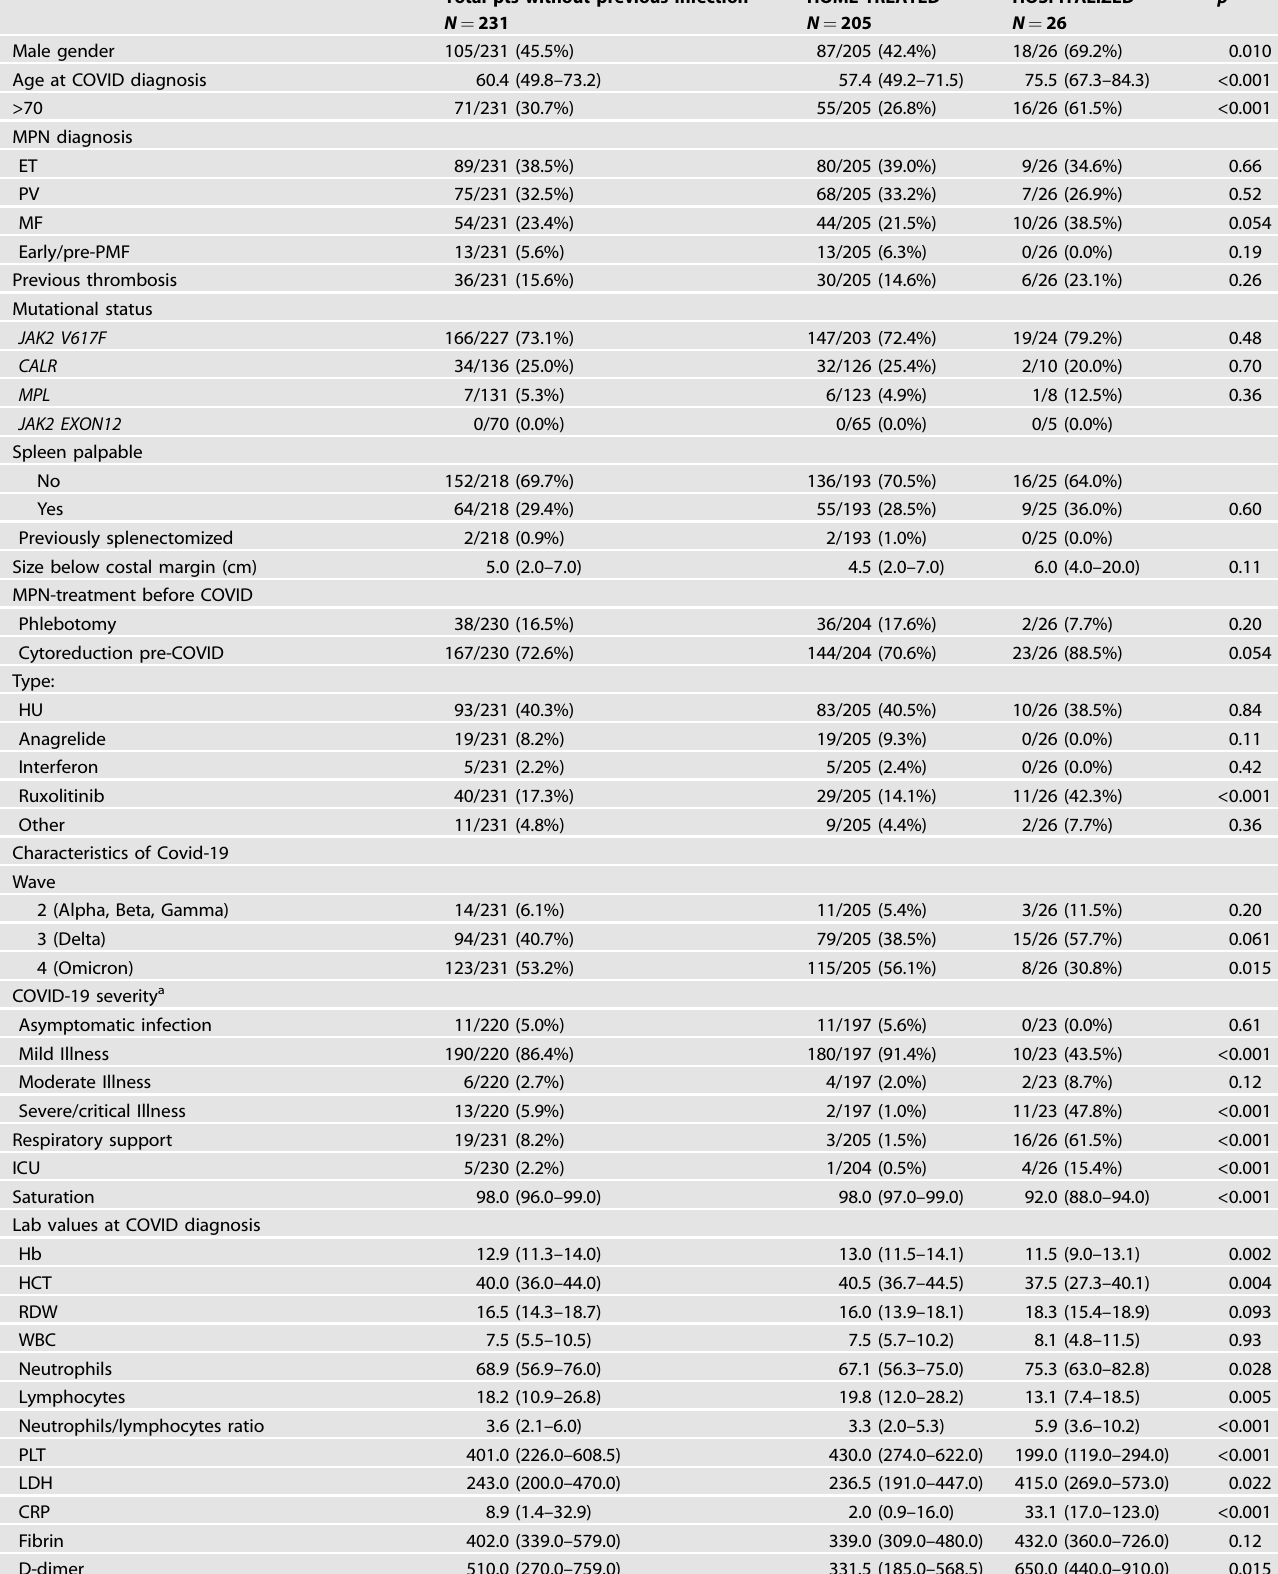
Table 2. Characteristics of vaccine breakthrough infections according to the severity of